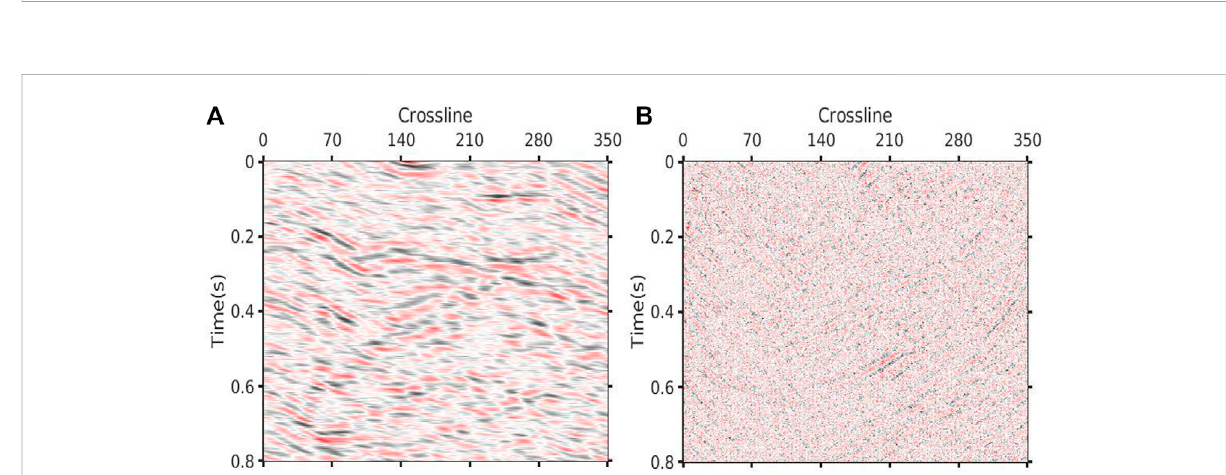
FIGURE 18 Denoising result via Shearlet. (A) Denoised data (SNR=3.93 dB PSNR=20.28 dB). (B) Removed noise.